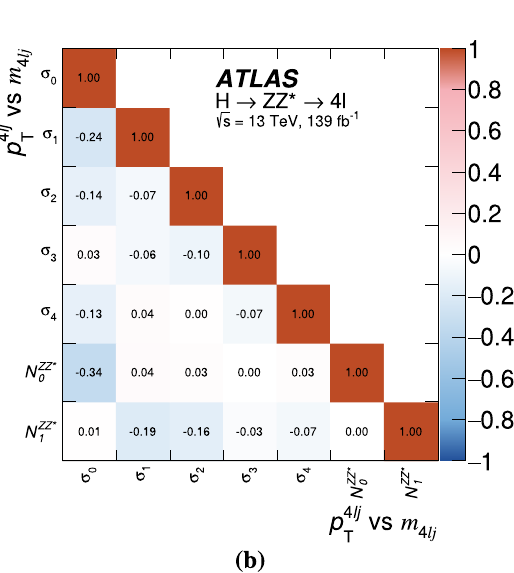
Fig. 36 a Double differential fiducial cross section for the transverse correlation matrix between the measured cross sections and the Z Z ∗ momentum of the four-lepton plus jet system vs. the invariant mass of background normalisation factors. The bin boundaries are defined in (cid:3) j Fig. the four-lepton plus jet system, p 4 vs. m 4 (cid:3) j and b the corresponding T